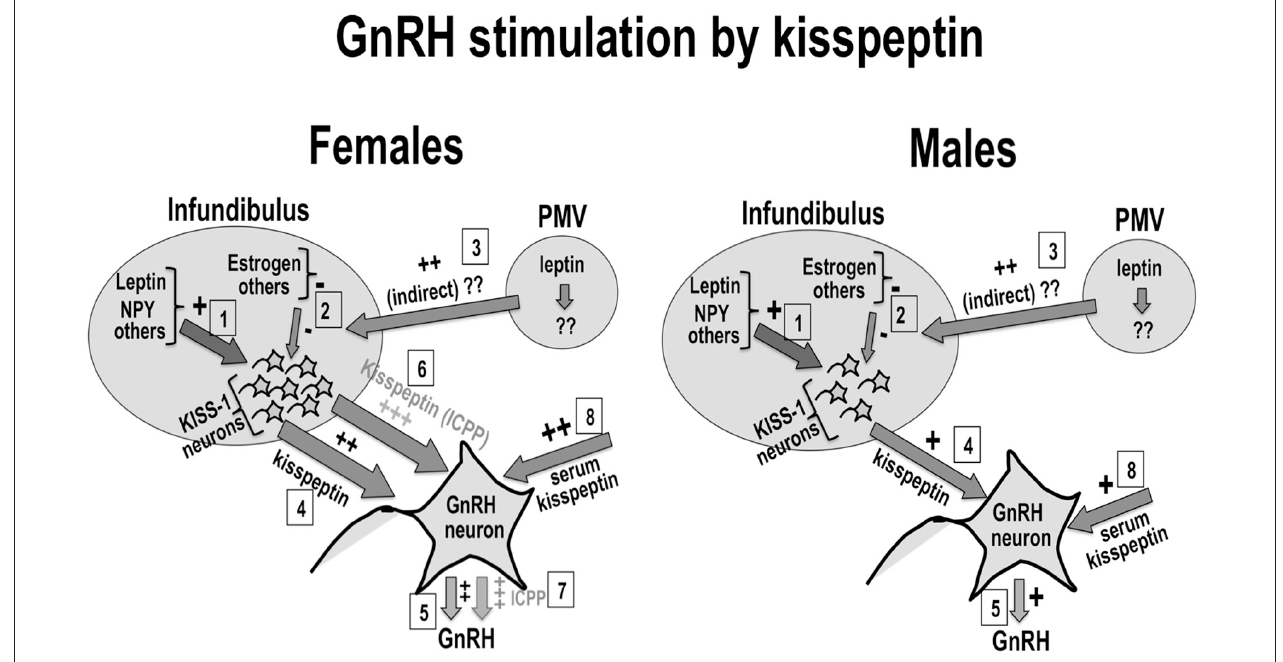
FIGURE 1 | Kisspeptin, sexual dimorphism, and puberty: Kisspeptin neurons (KISS-1) in the infundibular nucleus would be regulated by positive (1) and negative (2) inputs from nutritional, hormonal and environmental sources. Possible leptin input on kisspeptin neurons is shown in (1) and (3). Kisspeptin from KISS-1 neurons (4) or the circulation (8)